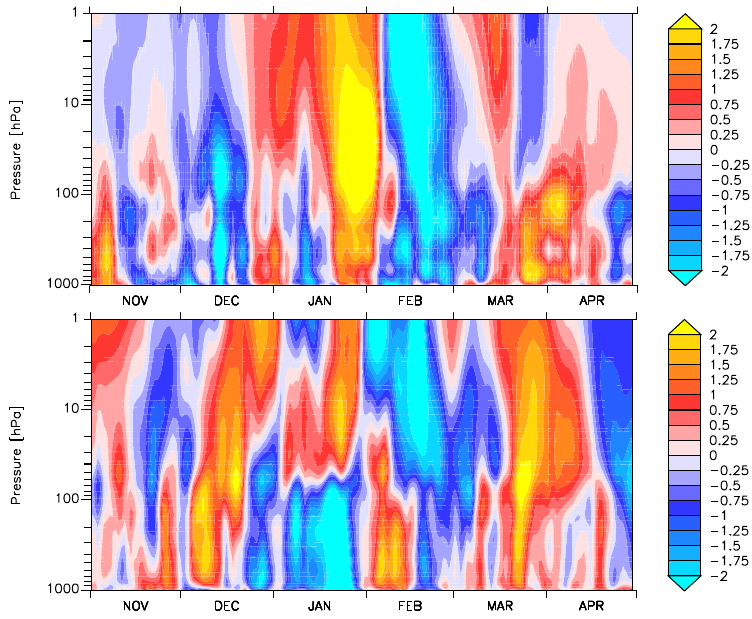
Fig. 12. NAM index for an exemplary winter calculated from simulation S-EPP (top) and S-noEPP (bottom). Red-yellow/blue colours indicate positive/negative differences.